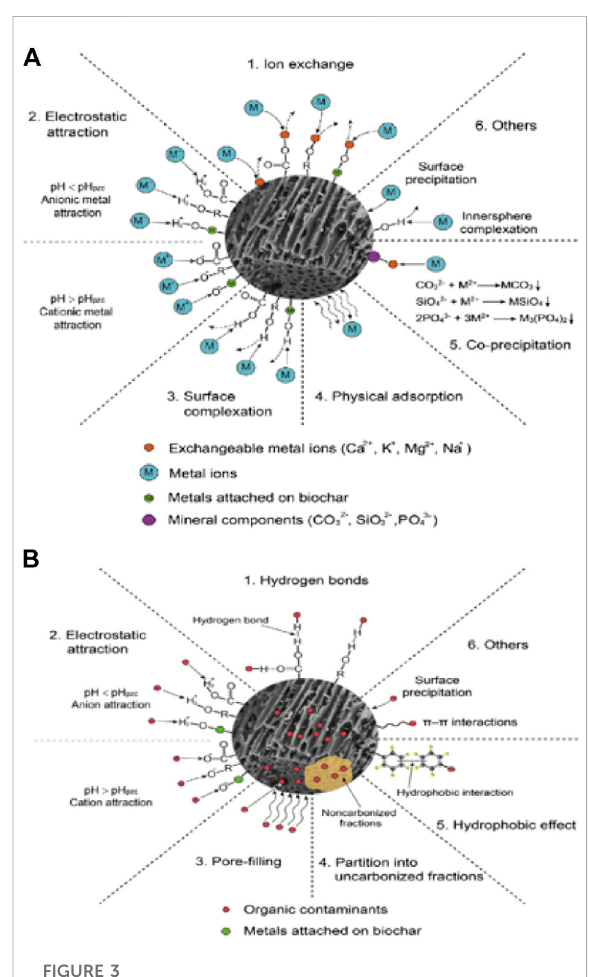
FIGURE 3 Modi fi ed/unmodi fi ed biochar possible adsorption mechanisms for antibiotic, inorganic, and organic pollutants (adapted from Tang et al.,